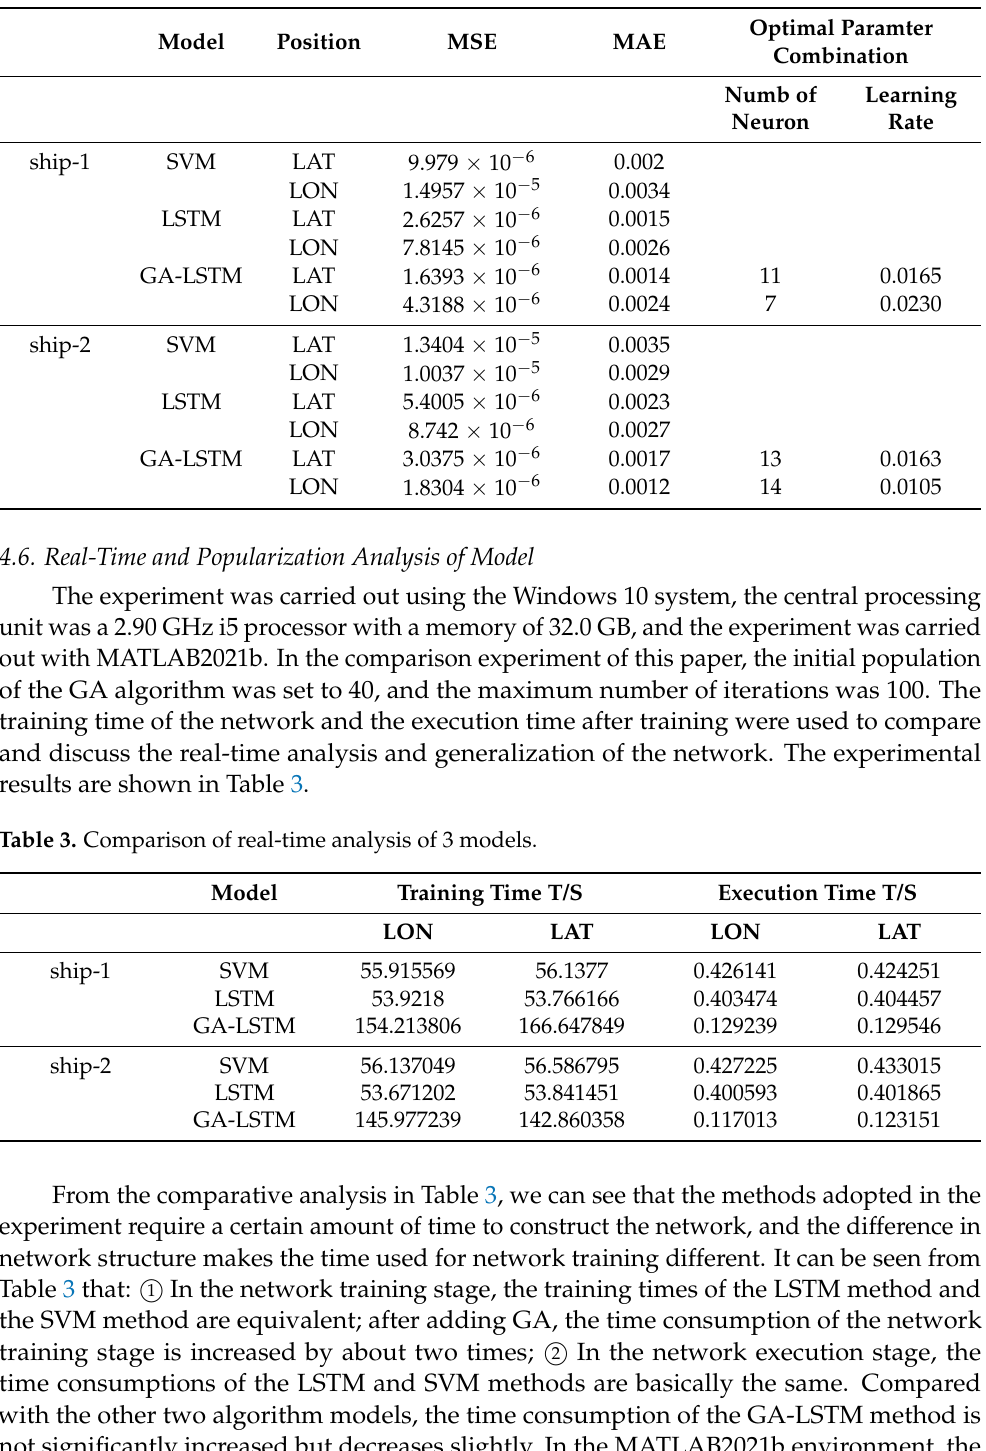
Table 3 that: 1 (cid:13) In the network training stage, the training times of the LSTM method